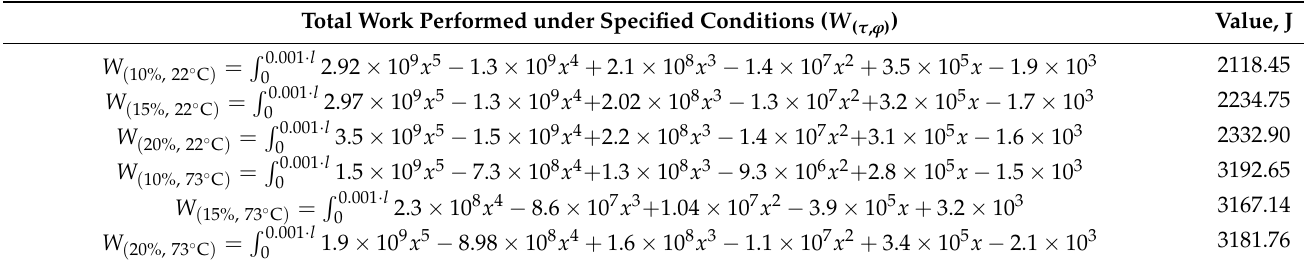
Table 5. Values of total compaction work with specific